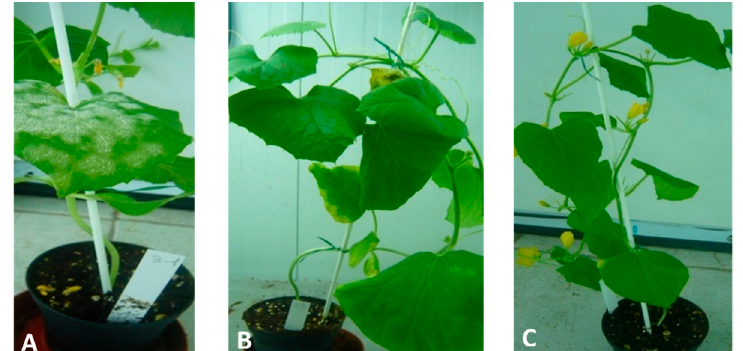
Figure 2. ( A ) Symptoms in susceptible control ‘Bola de Oro’ in comparison to the resistant accessions, ( B ) Tun-19 (Chamem) and ( C ) Tun-25 (Asli). All of them were inoculated with Race 2 of P. xanthii , with subsequent symptom evaluation 15 days post-inoculation in a growth chamber. Plants were scored according to the level of fungus sporulation using a scale of 0 to